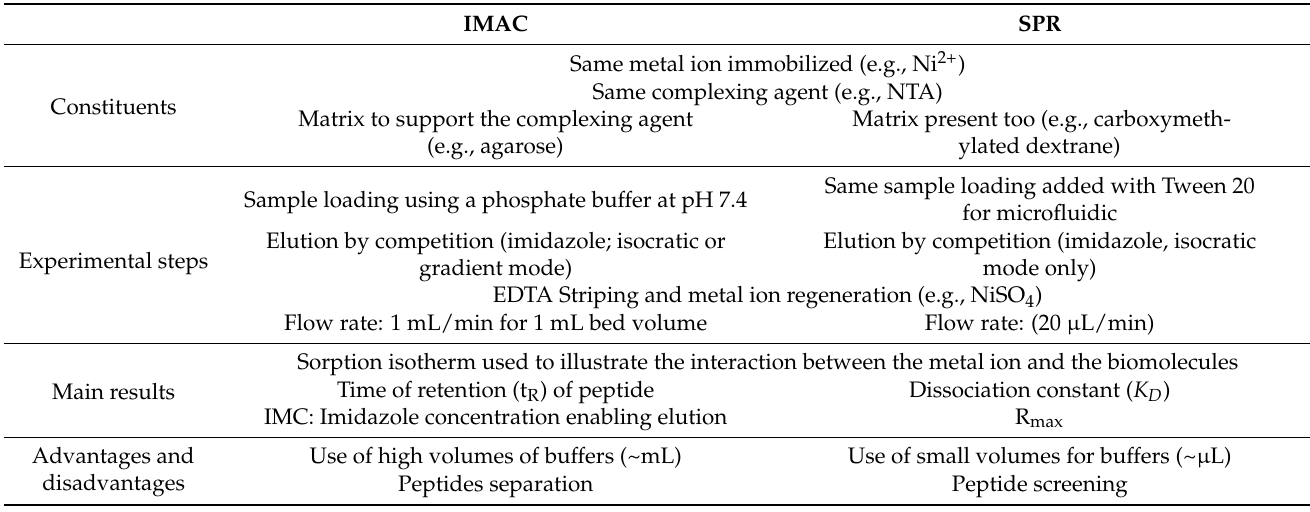
Table 3. The analogy between SPR and